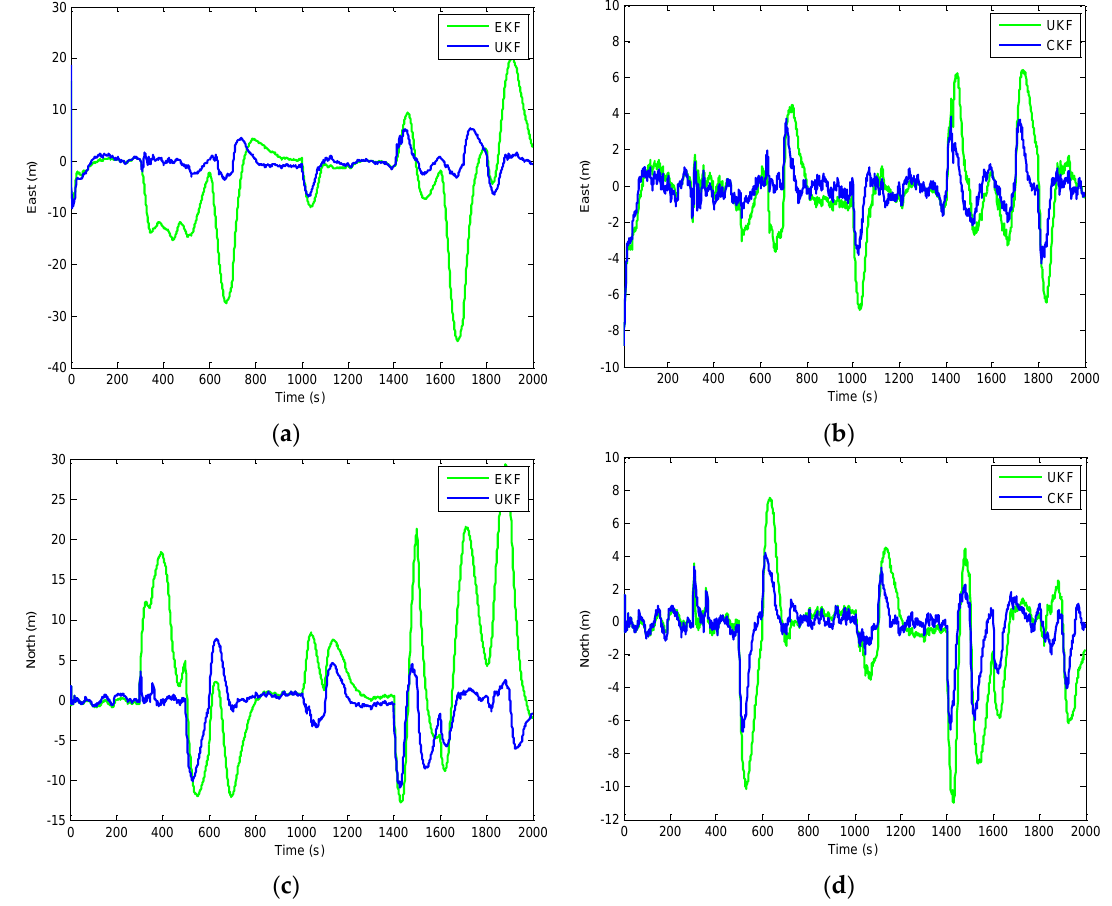
Figure 6. Position errors for EKF, UKF, and CKF—Scenario 1: ( a,c ) EKF versus UKF; and ( b,d ) UKF versus CKF.